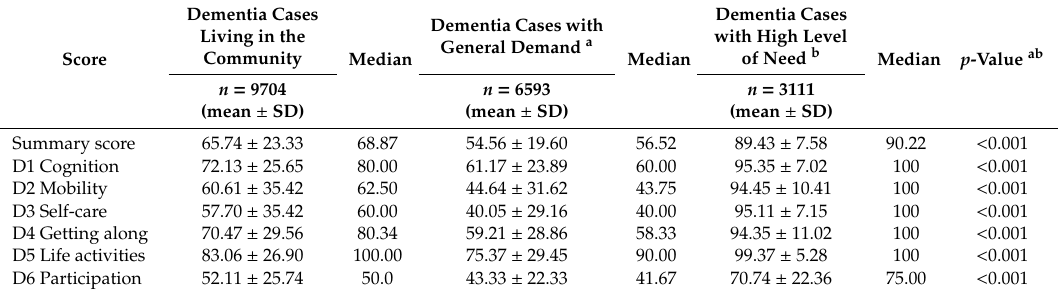
Table 2. Activity and participation functioning scores (WHODAS 2.0) of dementia cases in the current